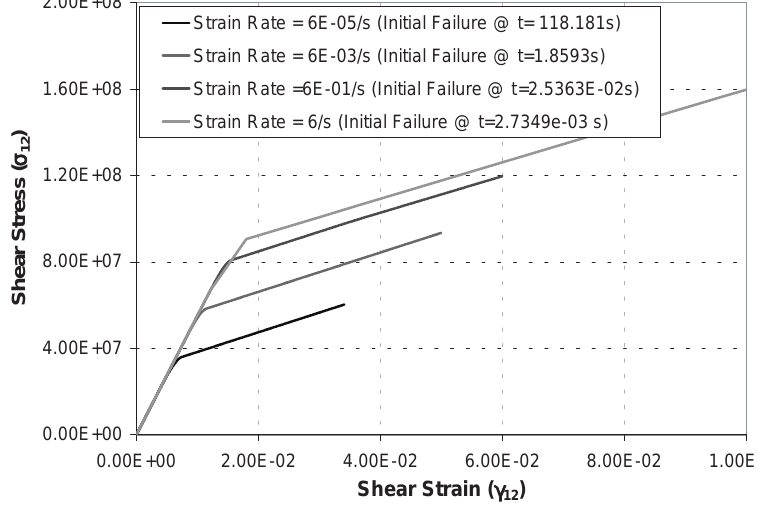
Fig. 5. Comparison of shear stress-strain response at various strain